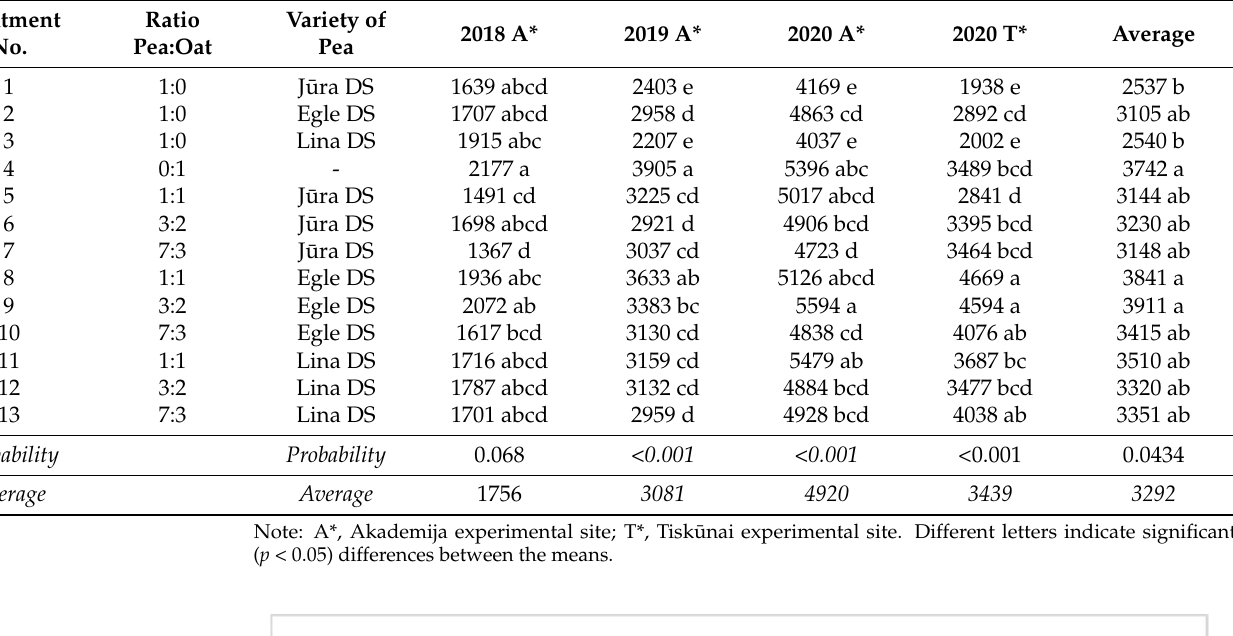
Figure 5. The grain yield of pea in the mixed cropping: difference between actual and expected grain yield.